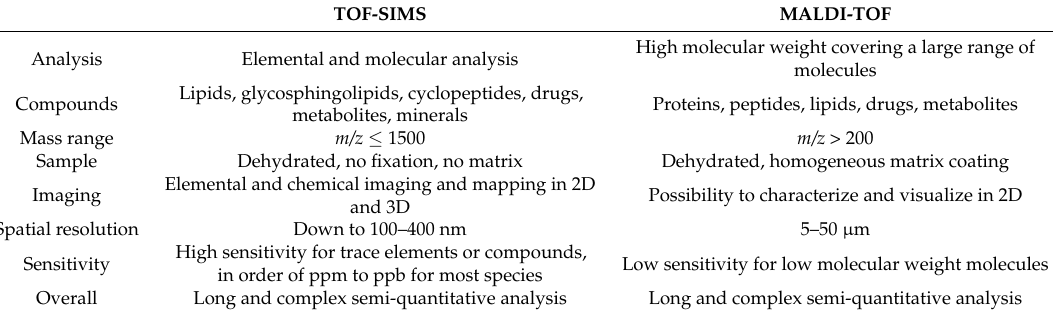
Table 1. Comparison of the features provided by Time of Flight Secondary Ion Mass Spectrometry (TOF-SIMS) and Matrix Assisted Laser Desorption Ionization - TOF (MALDI-TOF) in the context of mass spectrometry imaging